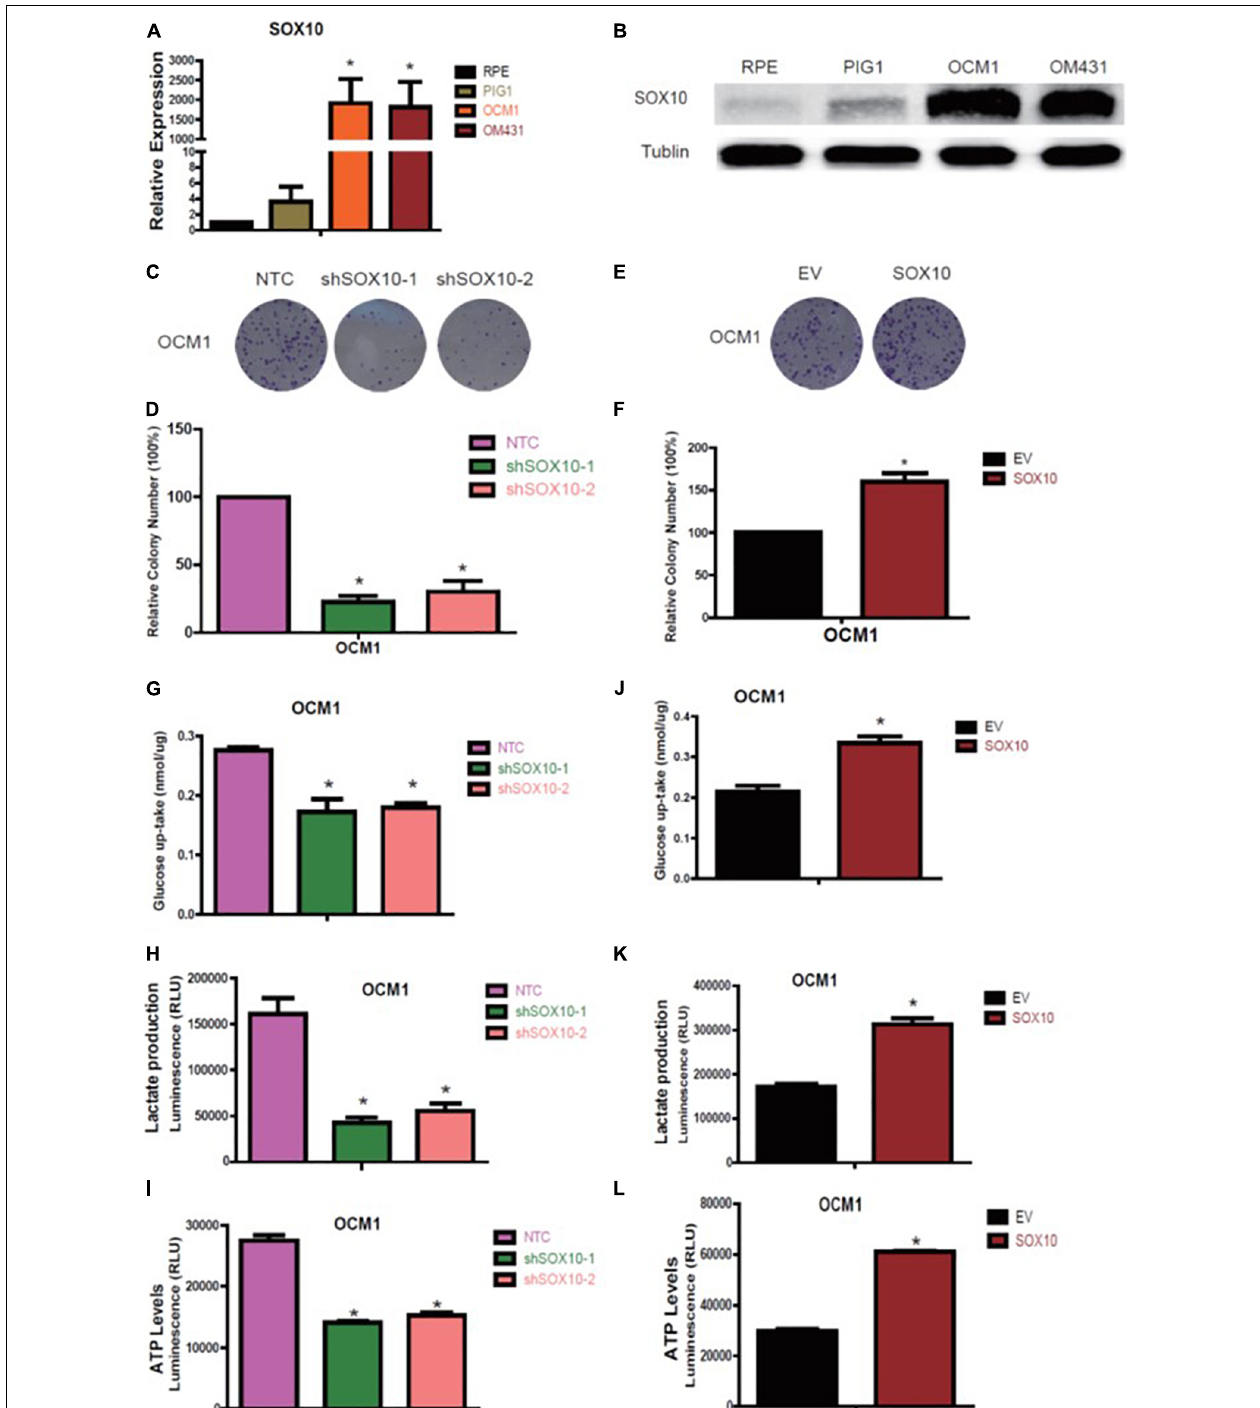
FIGURE 5 | SOX10 promotes proliferation and glycolysis in melanoma cell lines. (A,B) RT-qPCR and western blot analysis of SOX10 expression in OCM1 and OM431 cells. (C,D) Colony formation assay to assess the tumor colony forming ability of OCM1. Non-targeting control (NTC) indicates cells expressing NTC, and shSOX10-1 and shSOX10-2 indicates cells harboring shRNAs of SOX10. (E,F) Colony formation assay to assess the tumor colony forming ability of OCM1 cells overexpressing empty vector (EV) or SOX10. (G–I) Glucose uptake (G) , lactate production (H) , and cellular ATP levels (I) were measured in OCM1 cells stably expressing NTC or two shRNAs (shSOX10-1 and shSOX10-2) of SOX10. Data are presented as the mean ± SE. * P < 0.05 compared with the NTC group. (J–L) Glucose uptake (J) , lactate production (K) , and cellular ATP levels (L) were measured in OCM1 cells stably overexpressing empty vector (EV) or SOX10. Data are presented as the mean ± SE. * P < 0.05 compared with the EV